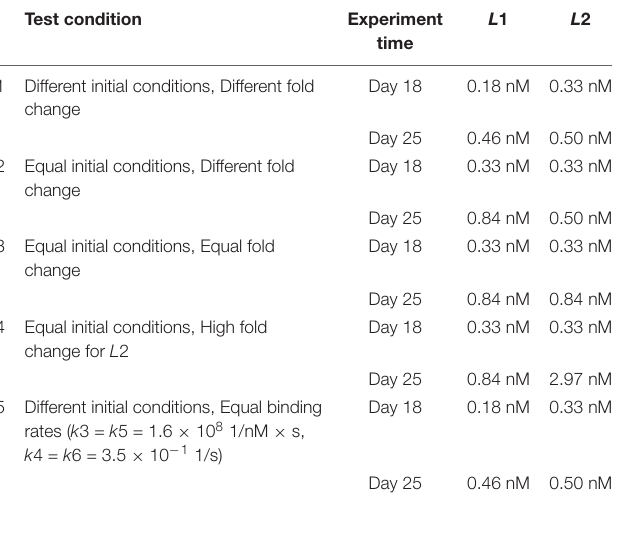
fold change (FC) between experiment days; different or equal binding rates (BR) for ligands] and for each time point (Day 18 and 25).